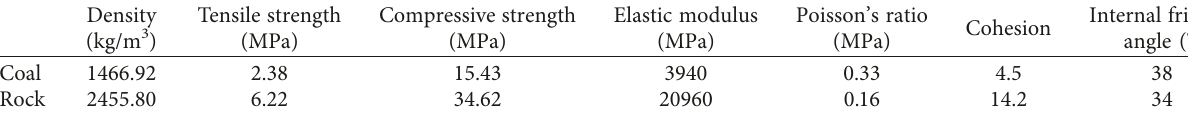
Table 2: Physical and mechanical parameters of